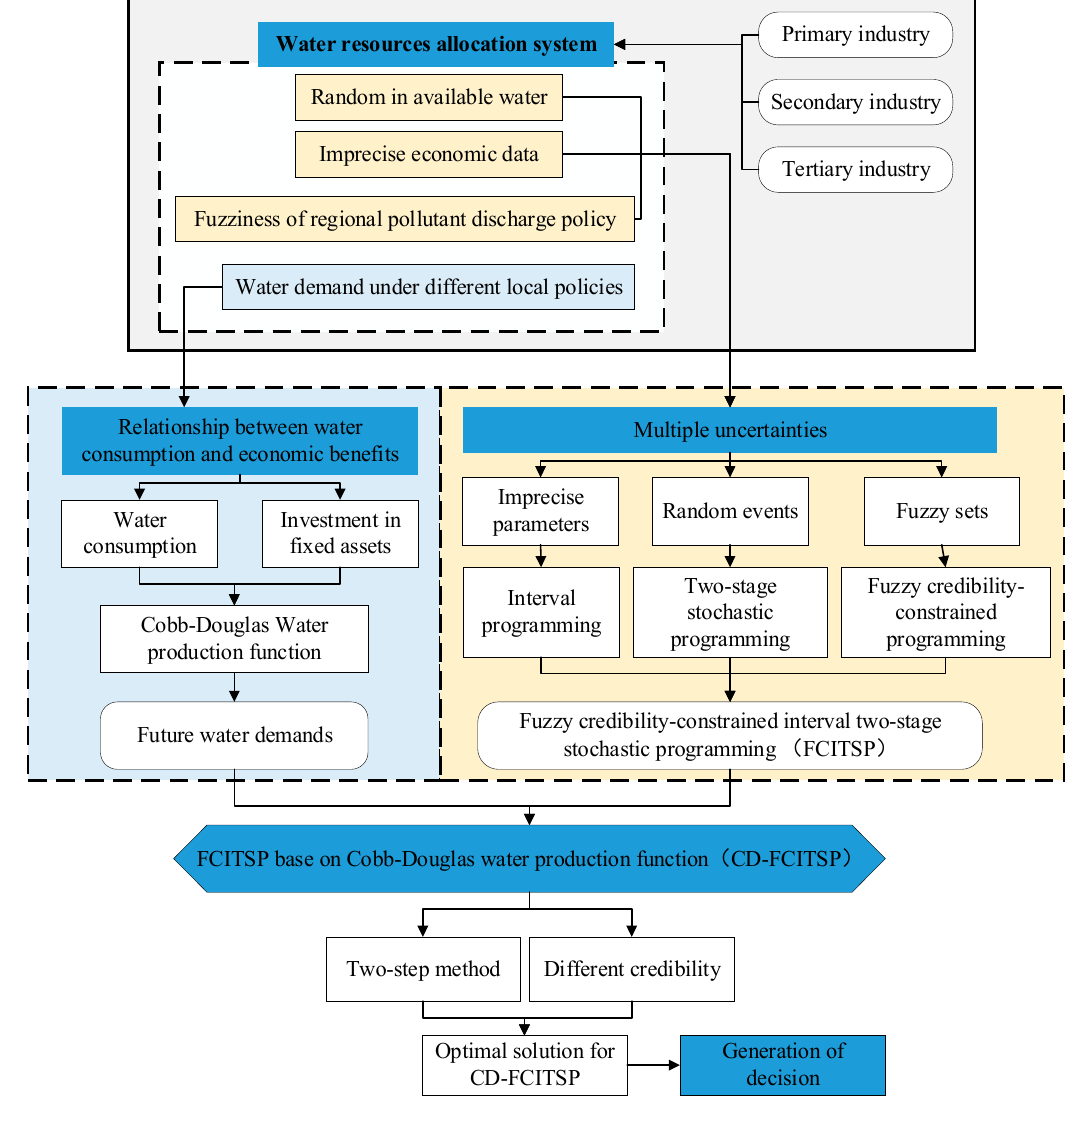
Figure 1. Framework of the CD-FCITSP model.